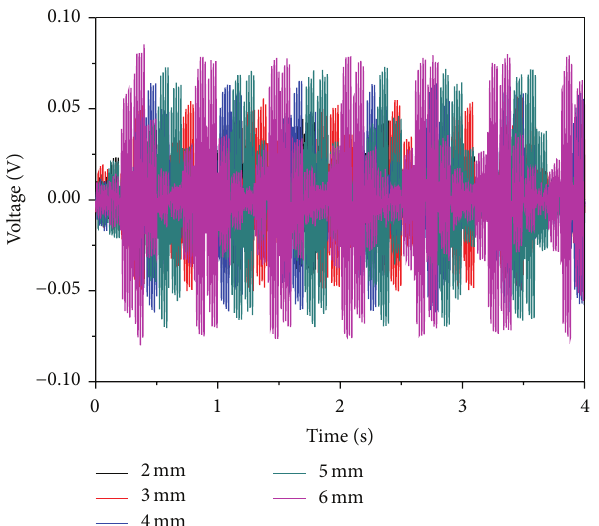
Figure 15: Self-induced voltage under different damper displace- ment.